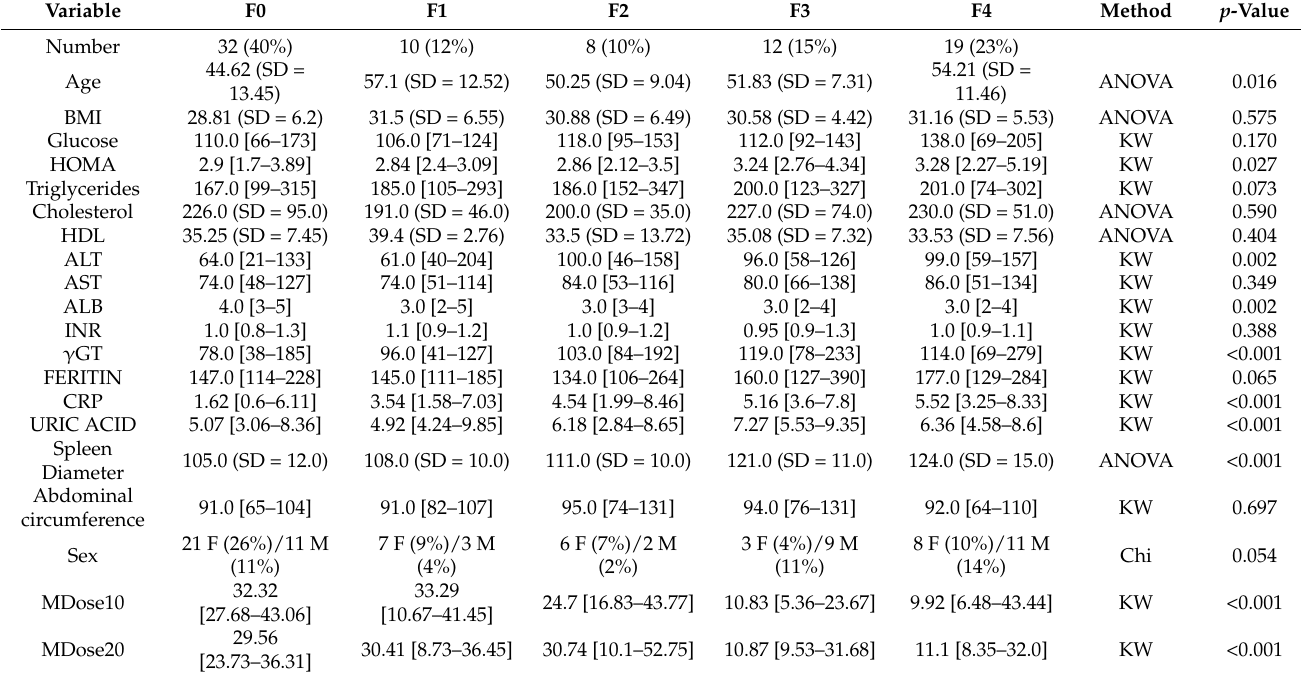
Table 1. Extended patient characteristics, by fibrosis